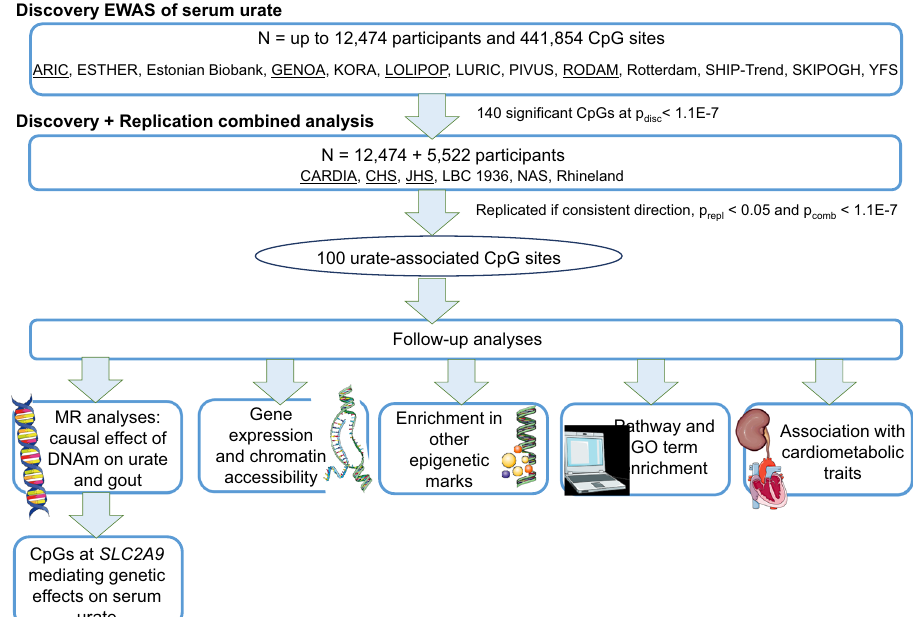
Fig. 1 Flowchart of analyses. MR Mendelian randomization, GO Gene Ontology. Icons were downloaded from smart.servier.com under the Creative Commons Attribution 3.0 Unported License.